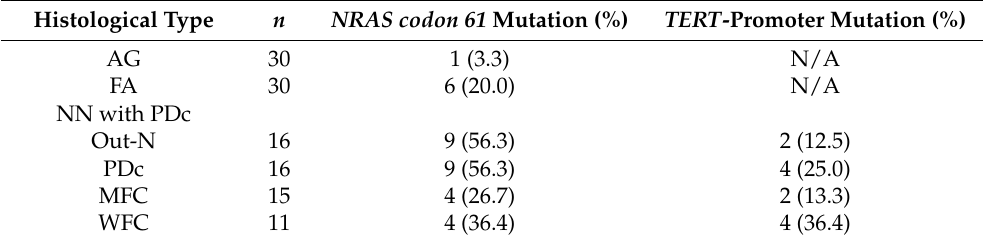
Table 3. NRAS codon 61 and TERT -promoter mutations in thyroid follicular-patterned tumors detected by droplet digital PCR.